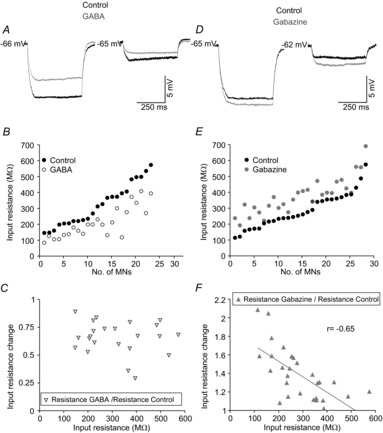
Effects of GABA (100 μm) or gabazine (20 μm) on input resistance of MNs from the rat oculomotor nucleusA and D, membrane potential responses to current steps of 20 pA in high- and low-input resistance MNs under control conditions and during exposition to GABA (A) or gabazine (D). B and E, plots illustrating the input resistance value of each MN under control conditions and during exposure to GABA (B) or gabazine (E). C and F, relationship between input resistance under control condition and input resistance change in response to exposure to GABA (C) or gabazine (F). Note that the input resistance changed linearly with input resistance in response to gabazine exposure, but not with GABA application. MNs, motoneurons.